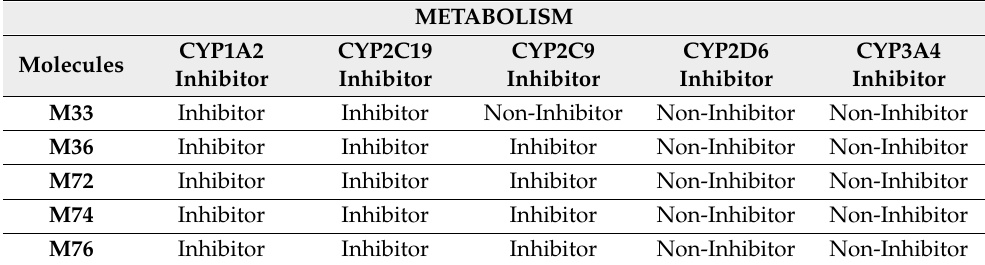
Table 5. Estimated metabolism parameters for the proposed pyrazole compounds.